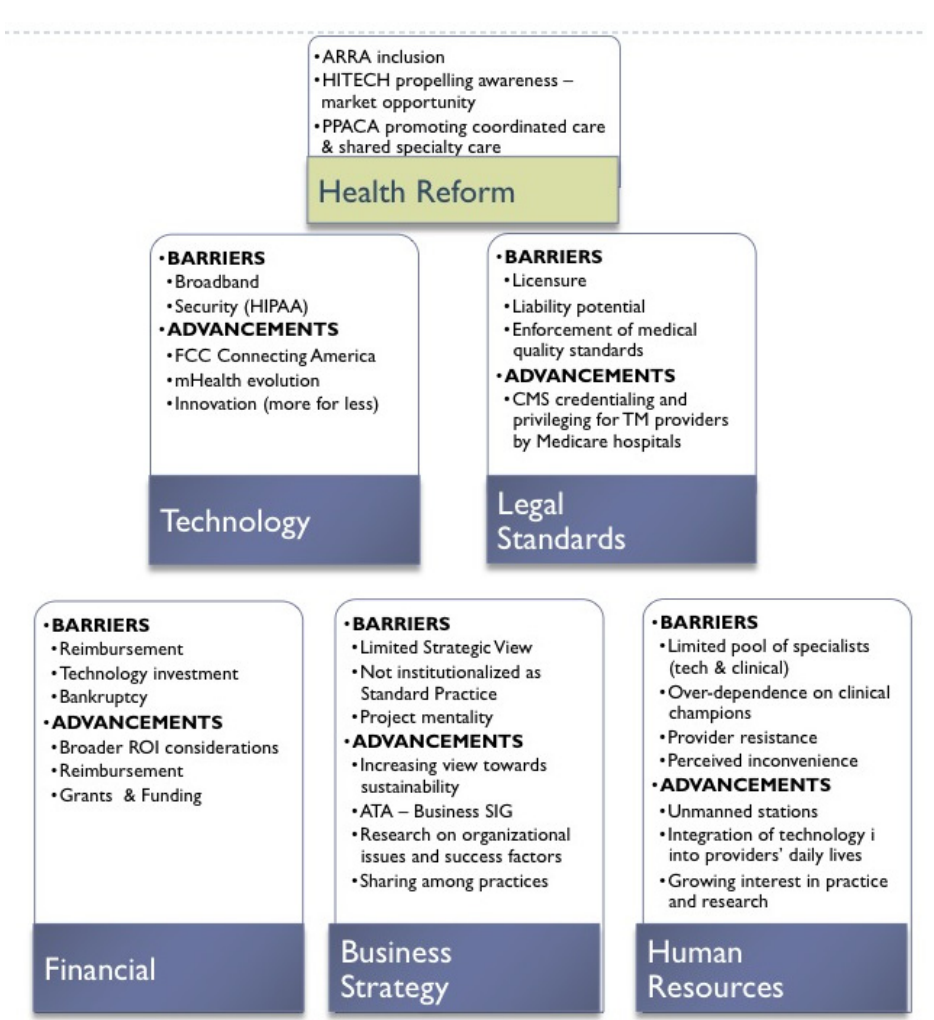
Figure 1. Telemedicine barriers and recent